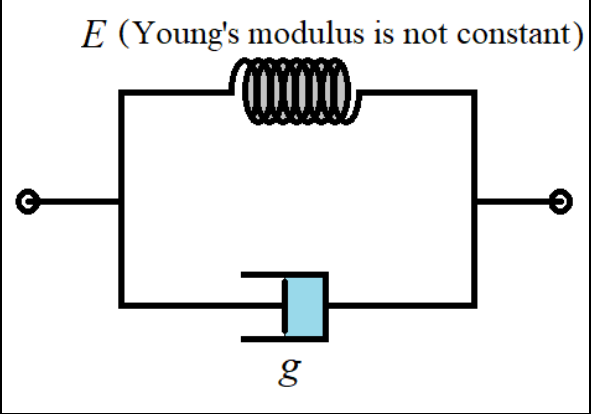
Figure 2. The Kelvin – Voigt model for viscoelastic property.